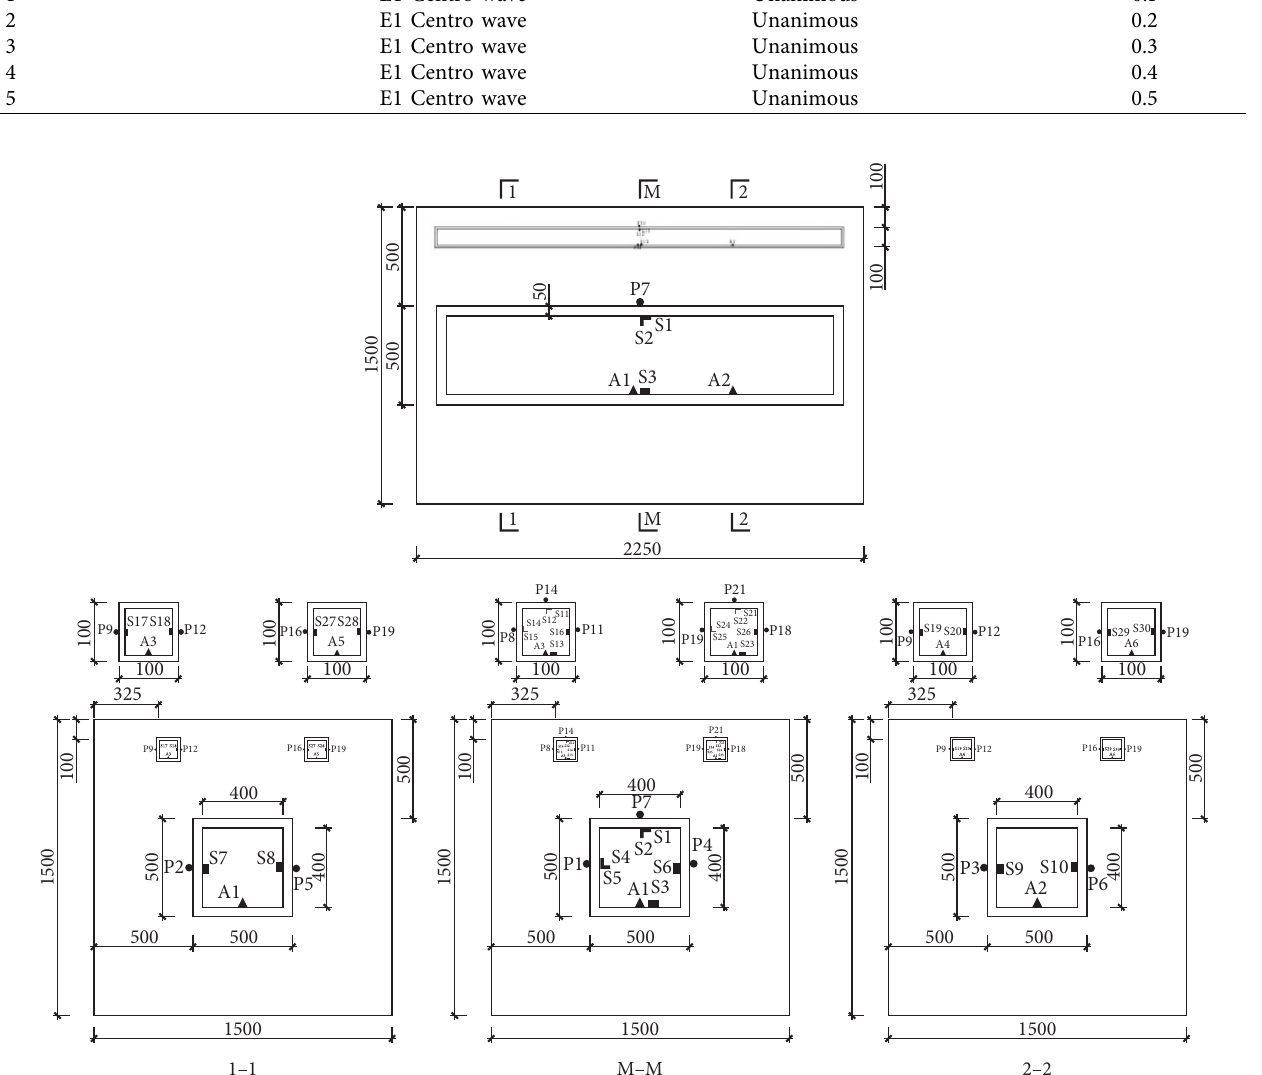
Figure 7: Conditions of sites and layout of